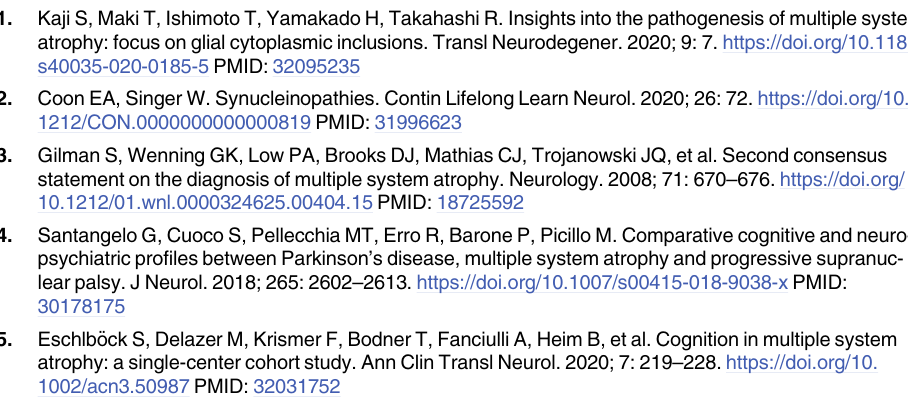
S1 Table. Comparison of SSR and Neurophysiological cardiovascular autonomic testing in MSA patients with and without dementia. S2 Table. Comparison of demographic, clinical and cerebral imaging data in MSA patients according to cognitive impairment level (without, mild and